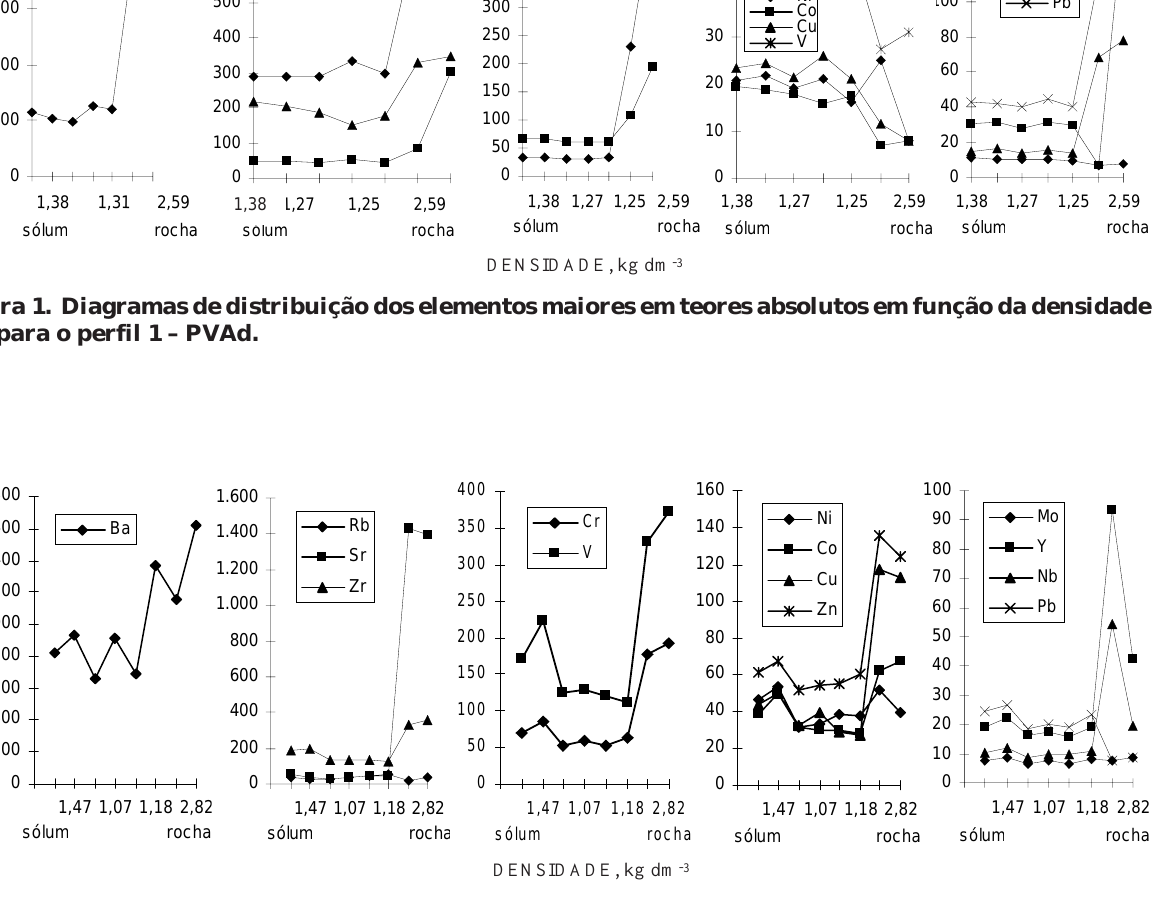
Figura 2. Diagramas de distribuição dos elementos maiores em teores absolutos em função da densidade para o perfil 2 – Pve.